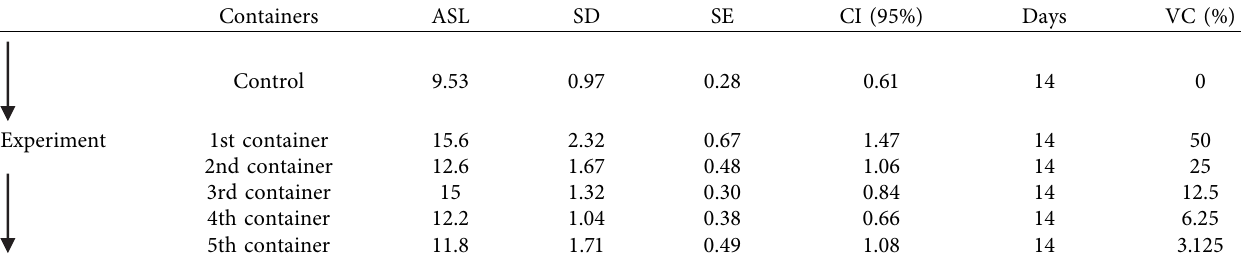
Table 7: Shoot length at the second week.